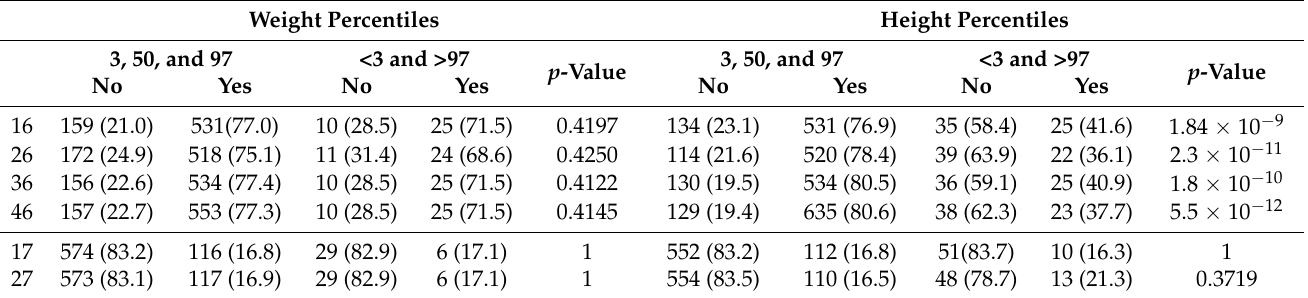
Table 6. Eruption of the molar group and its relation by hemiarch with weight and height